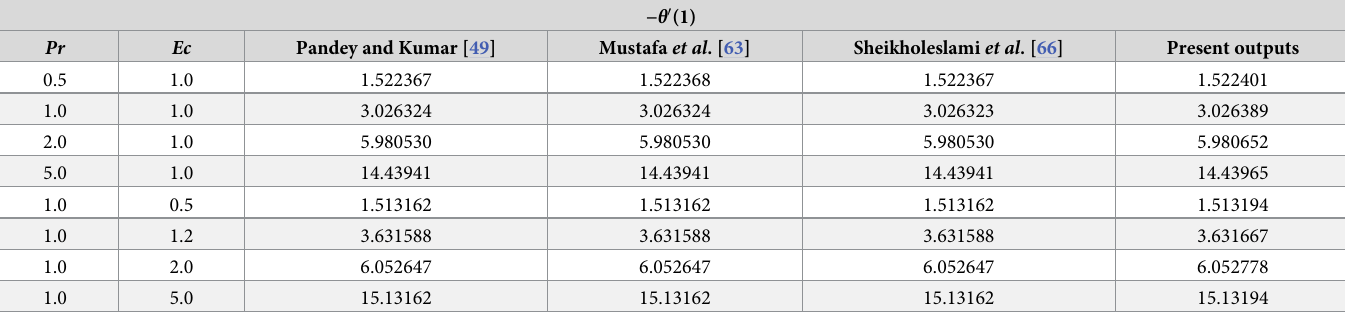
= De = 10 − 10 , Ha = γ = R b